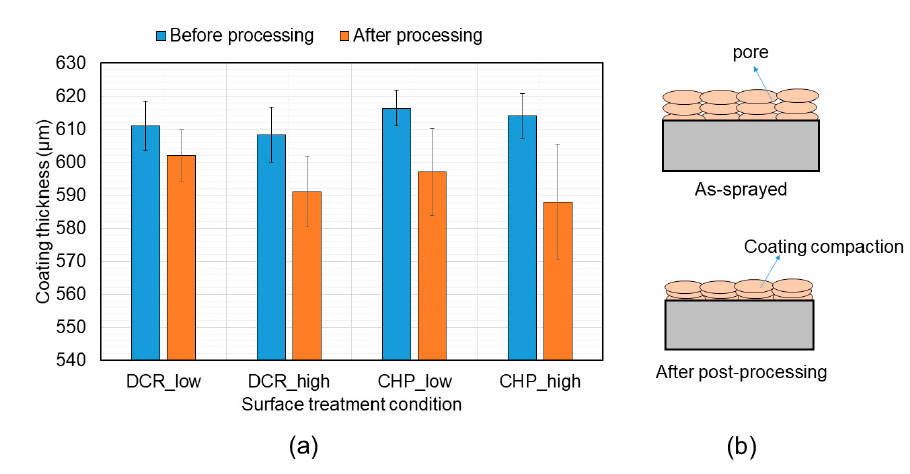
Figure 10. ( a ) Graph comparing the coating thickness of coupons treated under different conditions and ( b ) illustration of the compaction as a probable mechanism for porosity reduction.